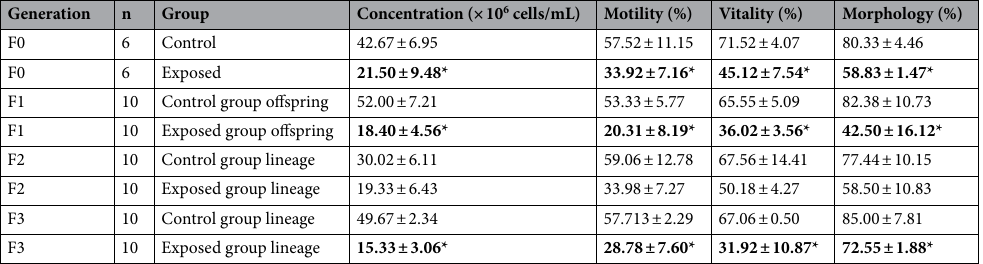
Table 3. Adult-onset sperm quality parameters over generations. (*) Statistically significant differences between control and arsenic exposed group (mean ± standard deviation) compared intra-generationally (F0- F3) (P <